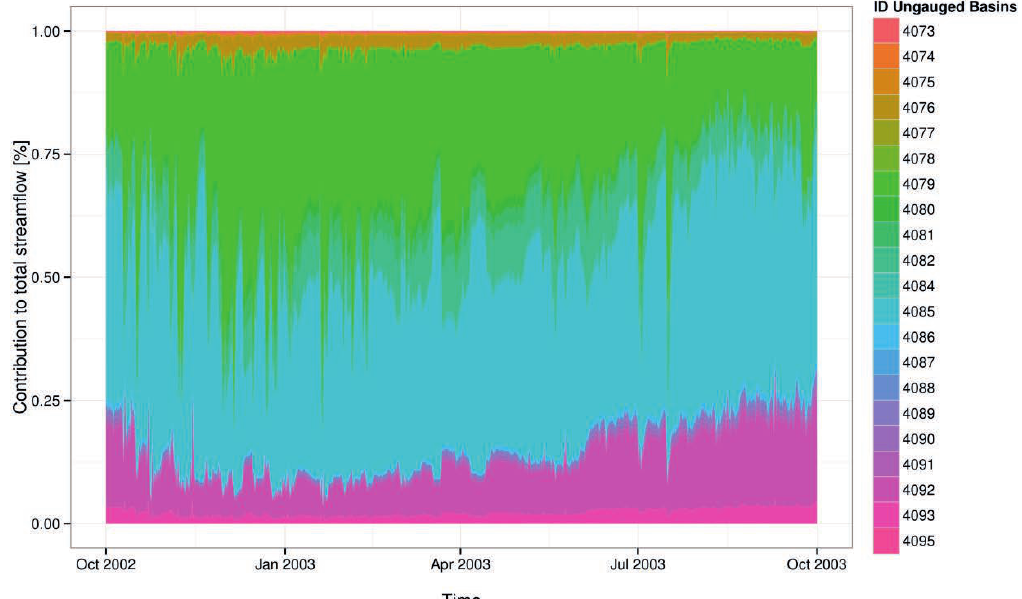
Fig. 4 Relative contributions to freshwater flowing into the bay of Saint-Brieuc at an hourly time